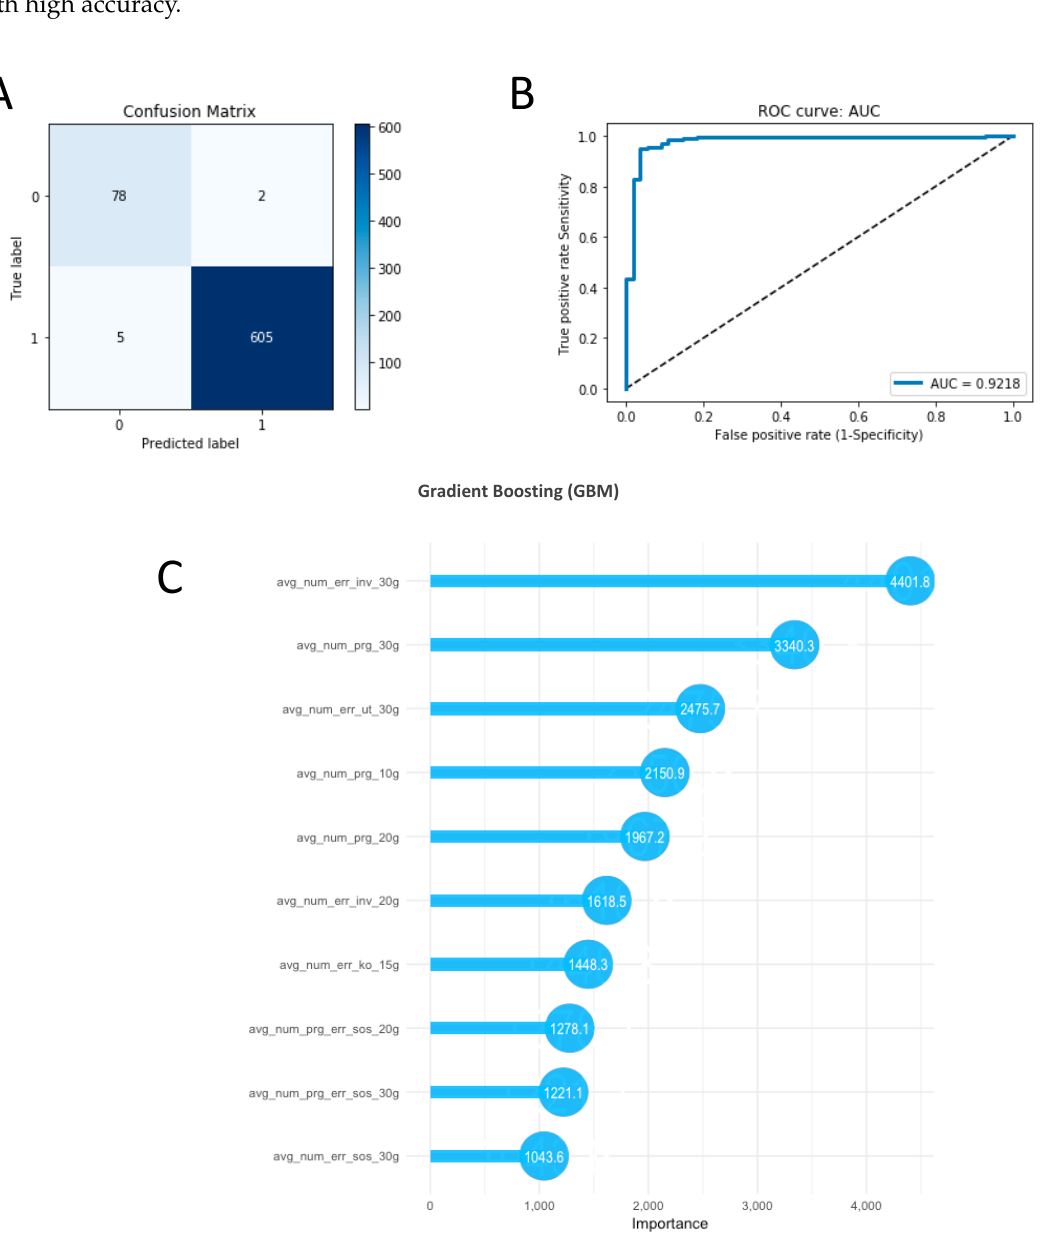
Figure 4. Classification metrics of Gradient Boosting Machine (GBM) classifier ( A ) Confusion matrix of GBM Classifier on testing data set. GBM classified 78 out of 81 records considering the machine down period (30-day Remaining Useful Lifetime (RUL) machine-down) and 605 out of 610 without machine down. ( B ) Receiver operating curve (ROC) of the machine down within 30-day RUL period and without machine down (control group; > 30-day RUL). The area under the curve was 92.18%. ( C ) Variable importance of GBM classifier. The horizontal plot shows top 10 variables selected from the model to classify machine down against the control